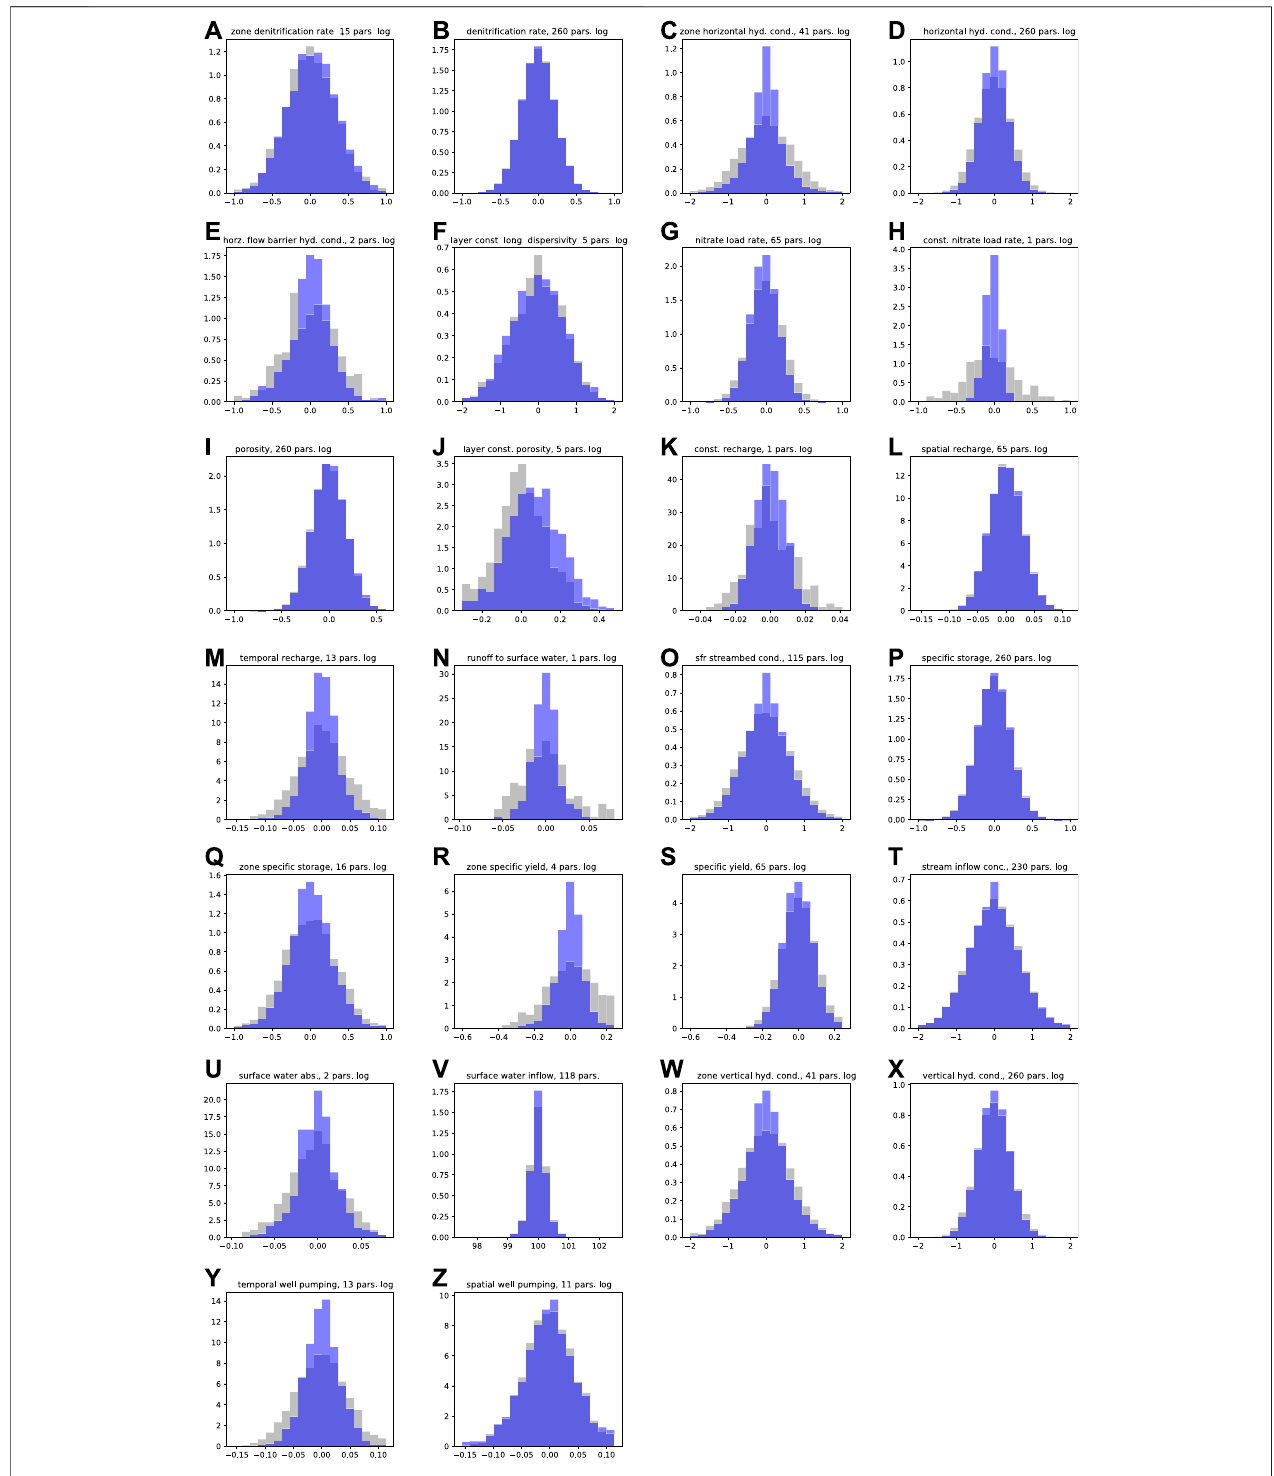
FIGURE 10 | Posterior parameter distributions (blue) plotted over prior parameter distribution (grey). The total number of parameters in the grouped distributions are detailed in the individual plot titles. If distributions refer to the log10 transformed parameters values, this is also detailed in the individual plots. Plot of grouped prior parameter distributions alone are presented in Supplementary Figure SI 3.8 .